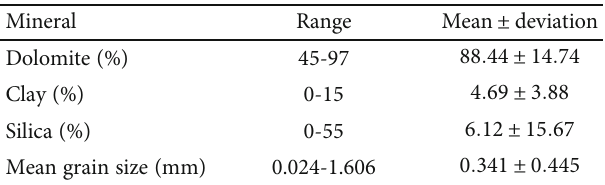
Table 6: Descriptive statistics of the main mineral composition in dolomite